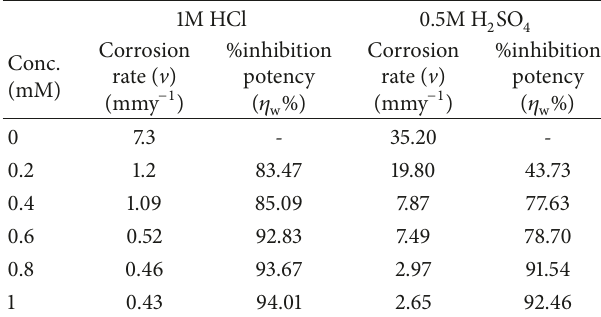
Table 1: The rate of corrosion of MS and corrosion